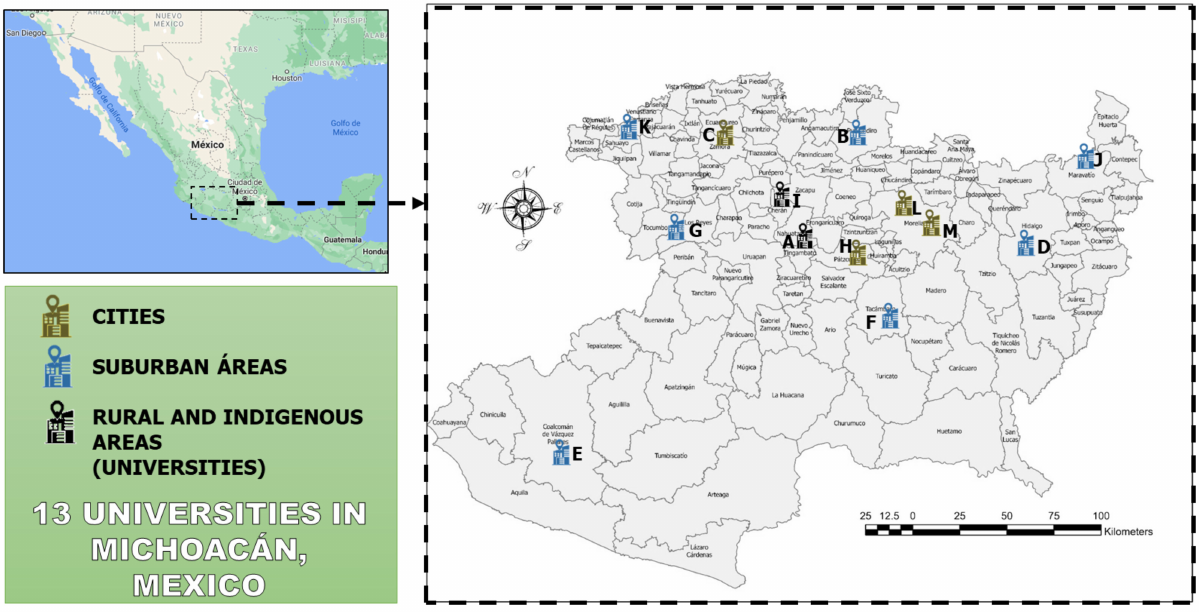
Figure 1. Location and distribution of the case